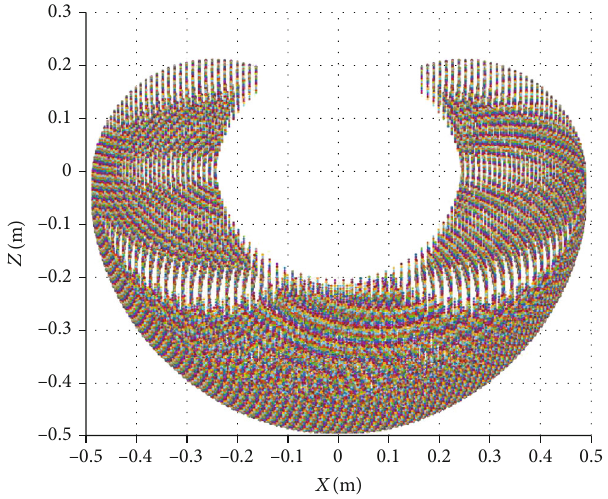
Figure 4: 3D workspace point map of one leg. Table 1: The twelve control points of the Bézier